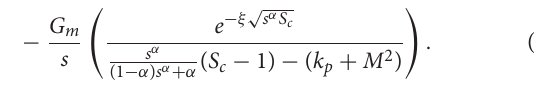
0.5, G r 2, P reff 0.1, G m 0.75, k p 1.5, and M = = = = =